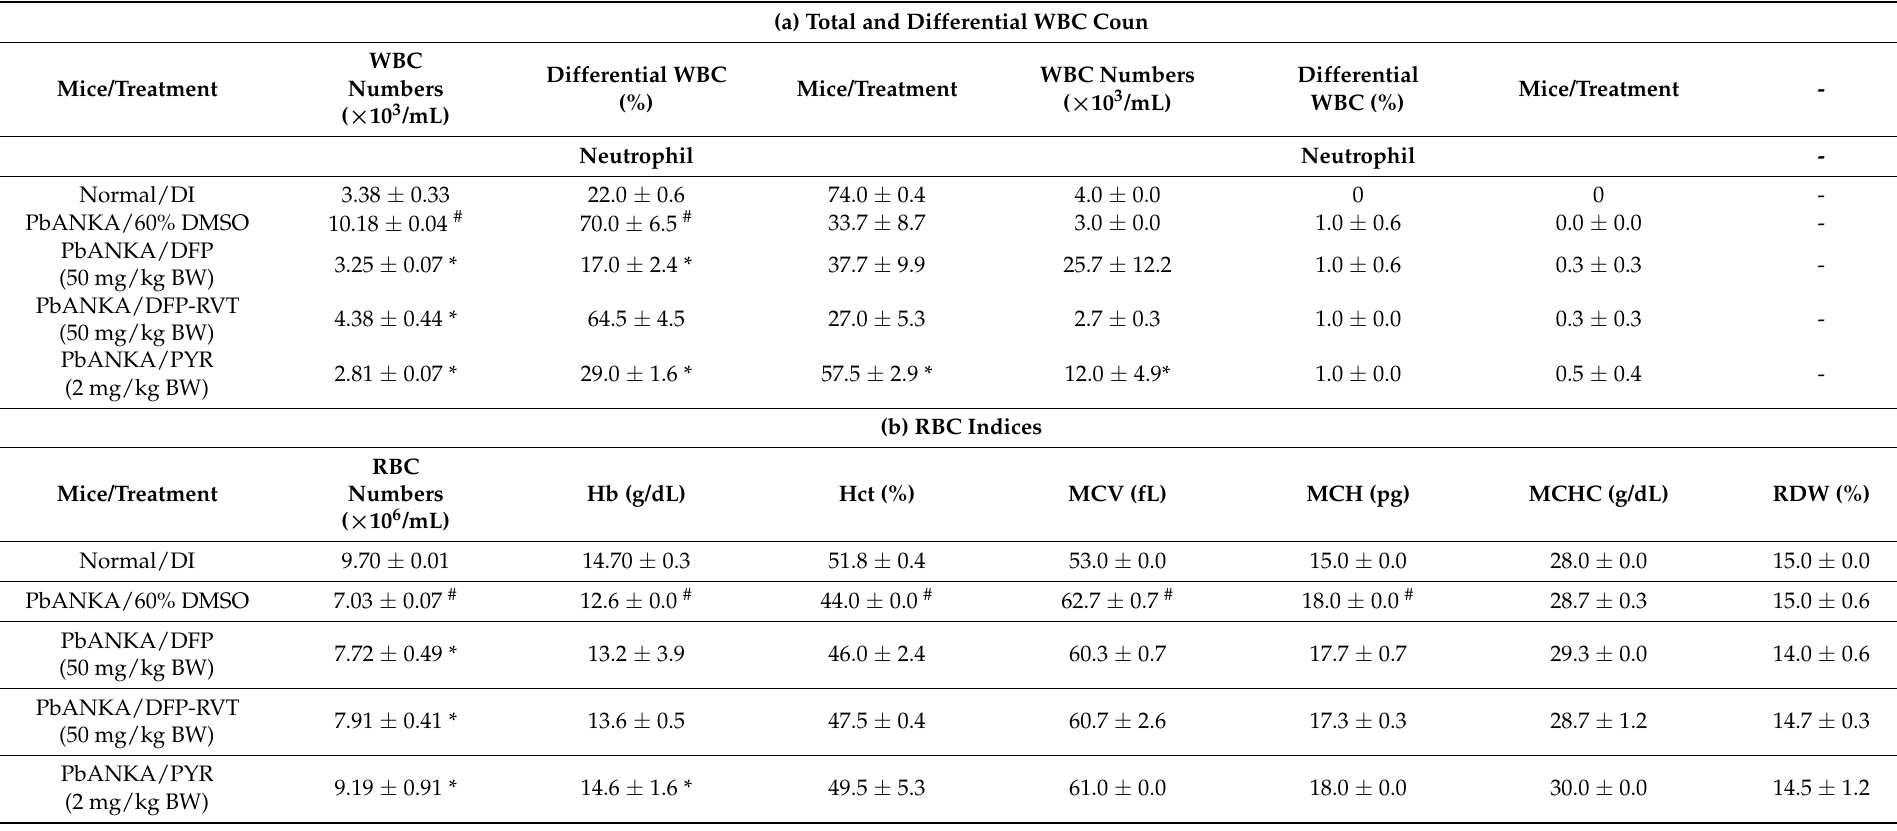
Table 1. Levels of hematological parameters in blood obtained from normal mice and PbANKA-infected mice treated with DMSO, DFP, DFP-RVT and PYR. Male ICR mice (n = 3 each) were infected ip with PRBC suspension (1 × 10 7 cells/mL with 5–20% parasitemia), then orally administered with 60% DMSO, PYR (2 mg/kg BW), DFP (50 mg/kg BW) and DFP-RVT (50 mg/kg BW) every day for 4 d. The mice were then humanely euthanized. Heart blood was collected into lithium heparin-coated tubes and were analyzed in terms of total and differential WBC numbers and RBC indices. Data are expressed as mean ± SEM values (n = 3). # p < 0.05 when compared to normal mice; * p < 0.05 when compared to PbANKA mice treated with